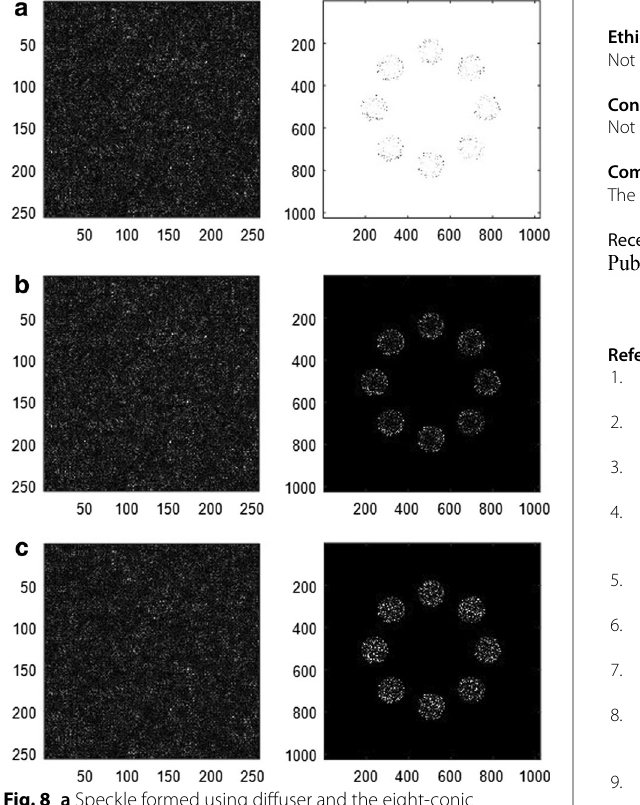
the apertures is computed and plotted. Finally, speckle imaging using diffuser limited by the manufactured aper- tures are computed and plotted. The reconstructed aper- tures are obtained from the speckle images which can be improved by filtering techniques.